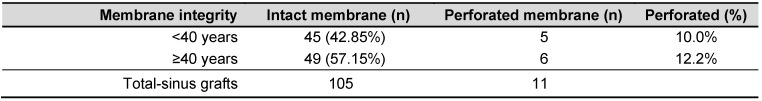
Membrane integrity at augmentation procedures with postoperative complications according to patient’s age